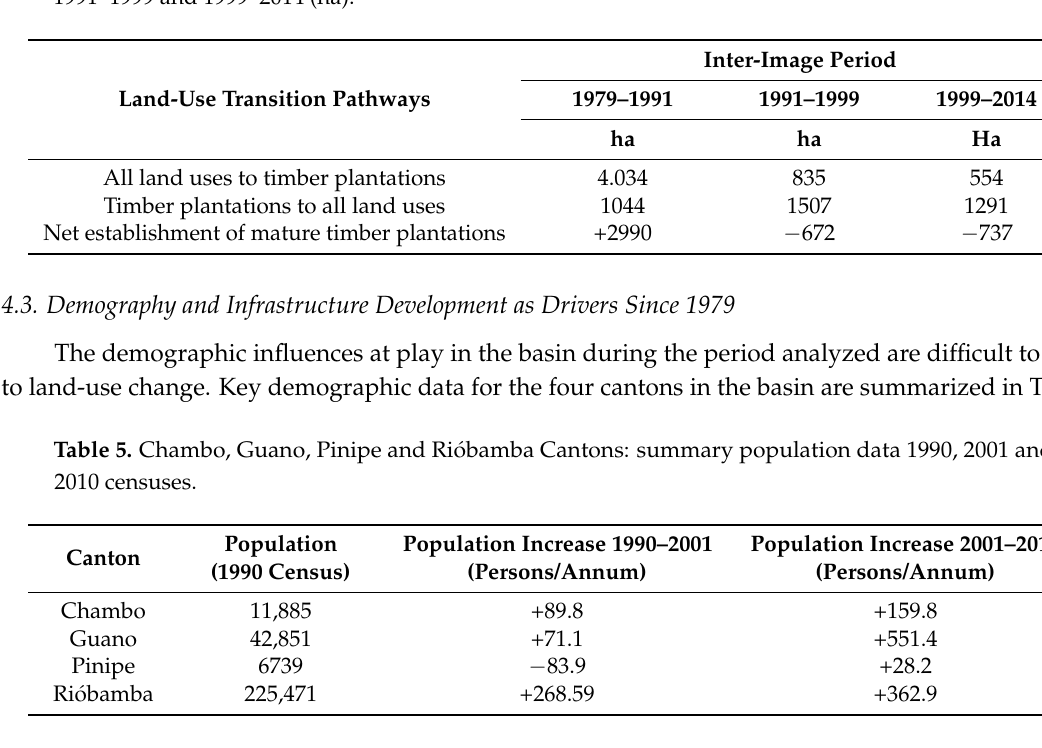
Table 4. Chambo basin: summary of land-use transitions involving forest plantations 1979–1991,